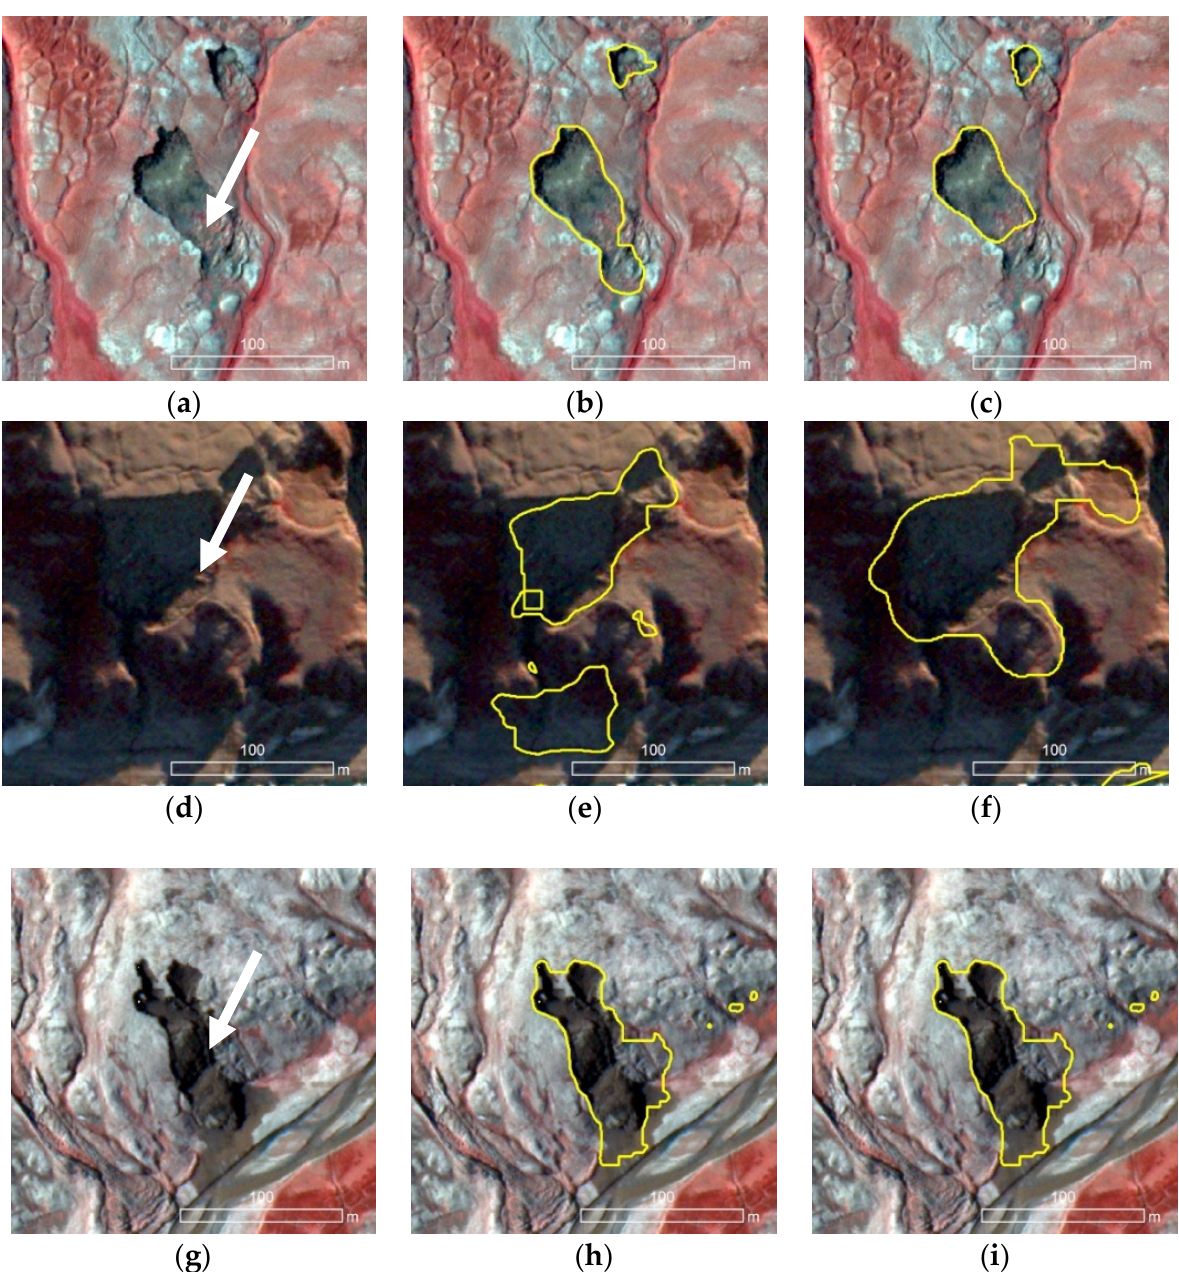
location of Banks Island and the Eureka Sound Lowlands. Examples exhibit training and prediction of input image tiles of 1024 × 1024 ( a , e , i ) without resizing 1024 × 1024 ( b , f , j ) and with resizing into two network input sizes: 512 × 512 ( c , g , k ), and 256 × 256 ( d , h , l ). Outline of the predicted RTS is shown in yellow outline. White arrows indicate the location of RTS. Underlying imagery is at 0.5 m resolution as false color composites.